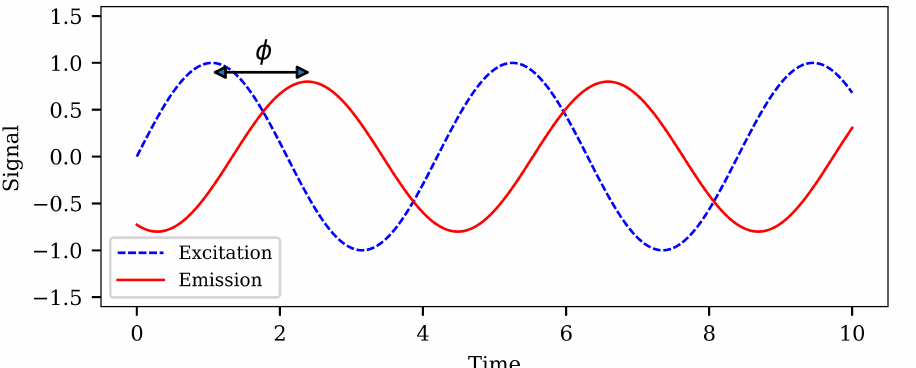
Figure 3. The basics of phase-fluorometry. The excitation signal (blue) is modulated by a frequency ω 0 . The photoluminescent response (red) has its intensity modulated with the same frequency, but as delayed by an amount φ